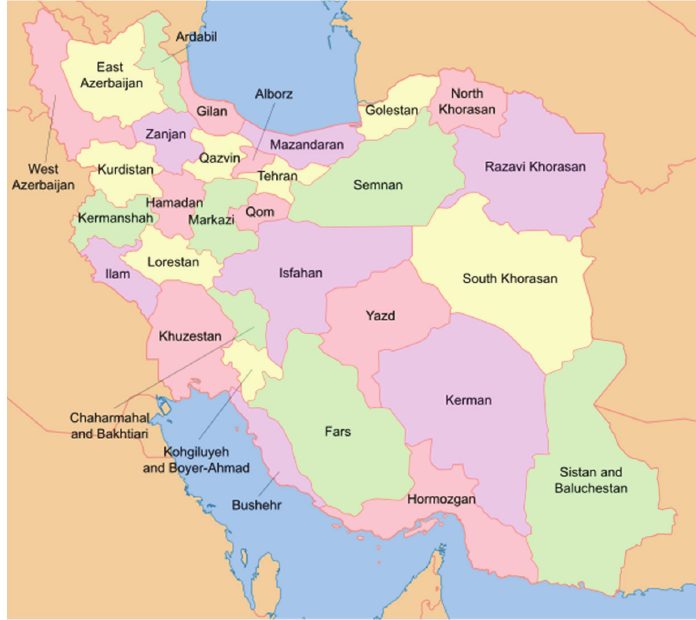
Fig. 2. The map of Iran and province of